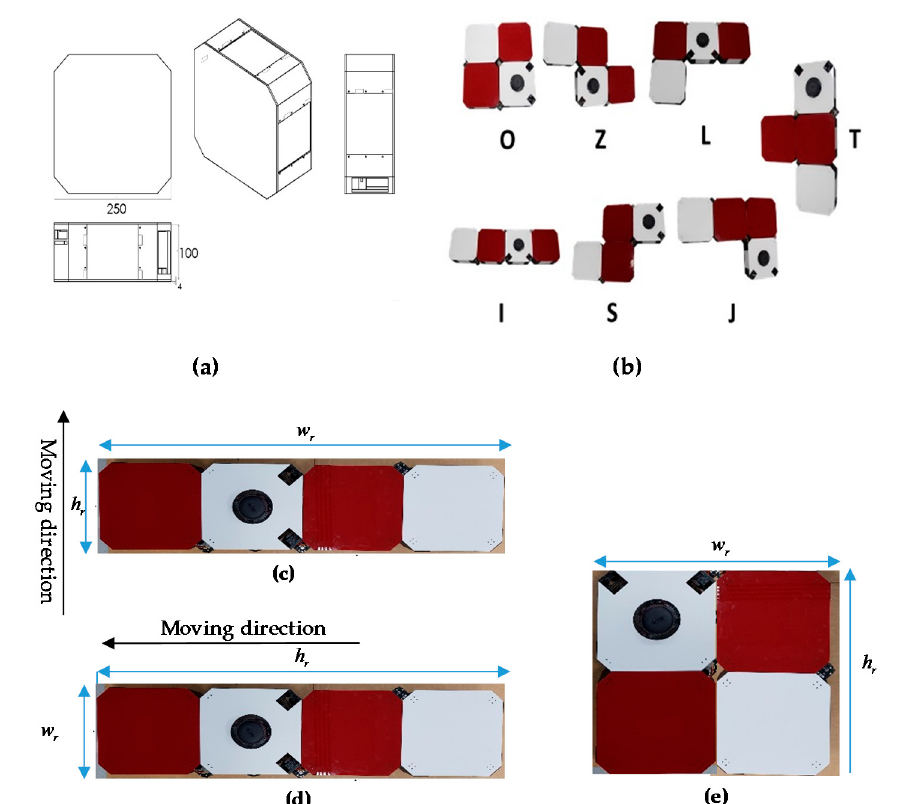
Figure 3. hTetro Single Block Dimension and morphologies. ( a ) Single Block Dimension, ( b ) seven hTetro morphologies, ( c ) I shape in vertical moving direction, ( d ) I shape in horizontal moving direction, ( e ) O shape.